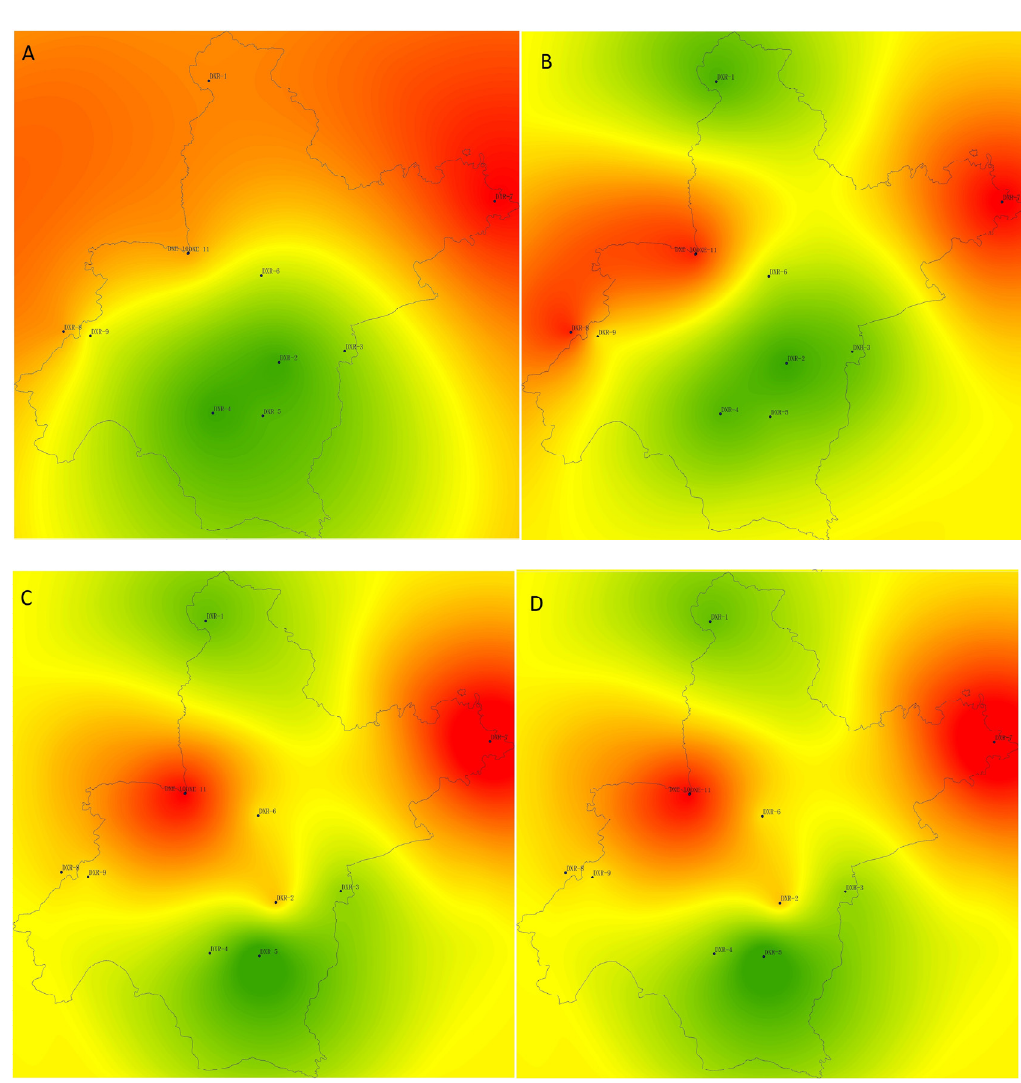
Figure 7. Kriging interpolation map of outcrop hot spots in Wuhan. ( A ) Recharge Elevation. ( B ) Age. ( C ) Heat storage temperature. ( D ) Depth of circulation. The value increases as the color deepens.